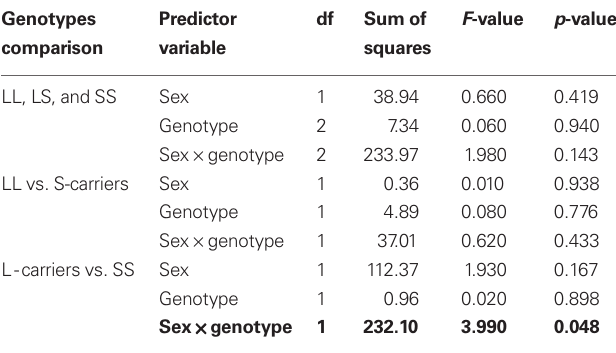
Table 2 | Results of general linear model for the 5 ′ -HTTLPR genotypic associations with age of onset of methamphetamine